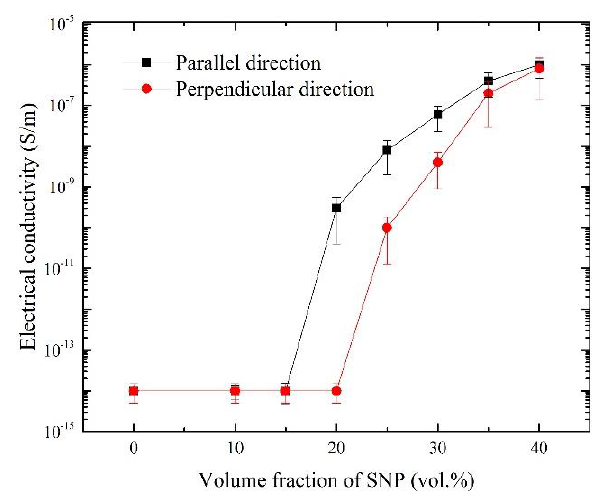
Figure 7. Electrical conductivity of SNP/PDMS composite. Table 2. Summary of electrical conductivity of SNP/PDMS composite.